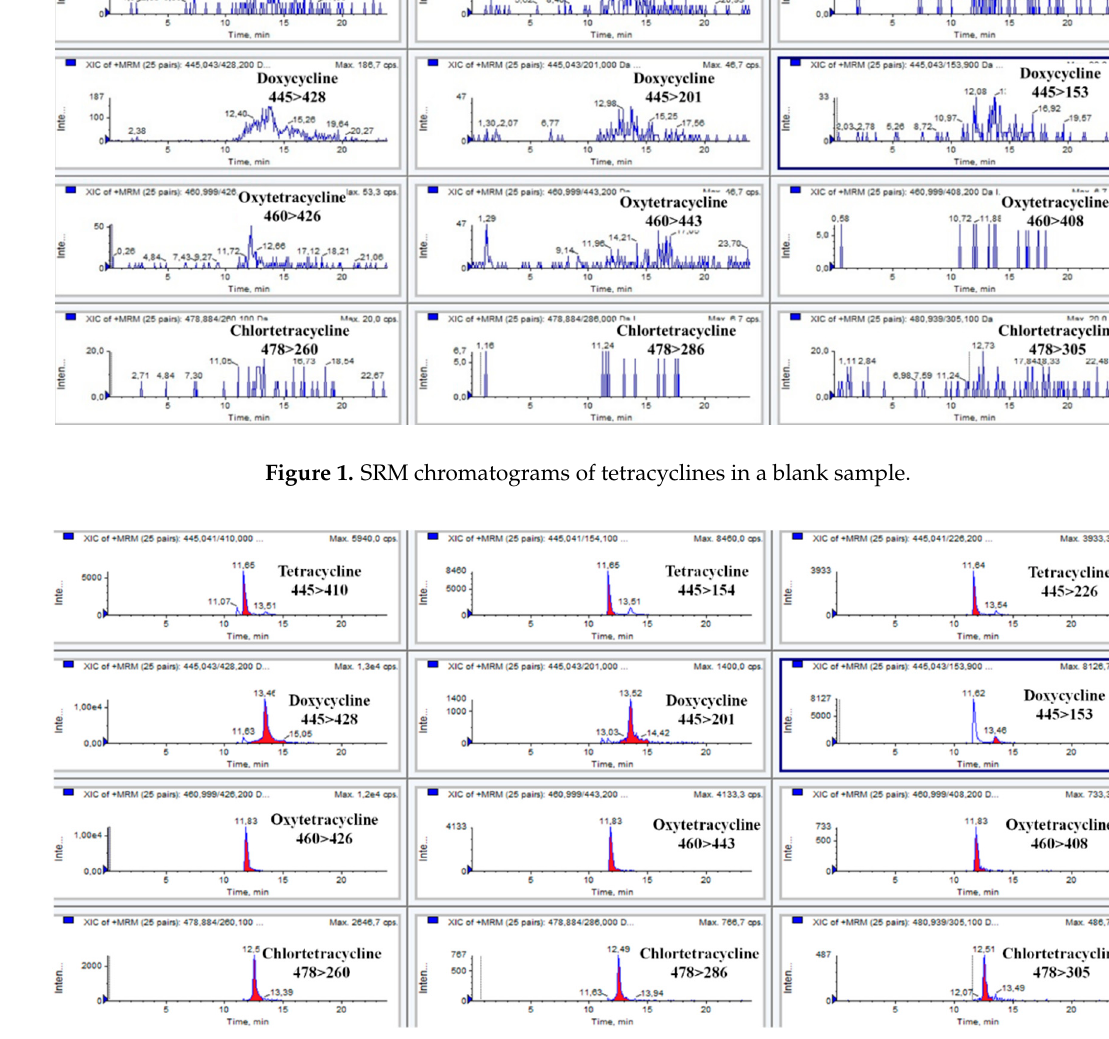
Figure 2. SRM chromatograms of tetracyclines in a sample fortified at 50 mg/kg.